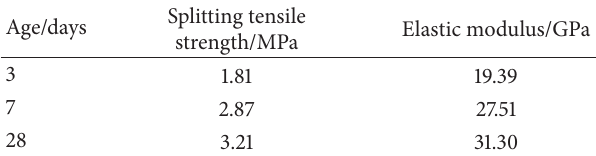
Table 3: Mechanical properties of